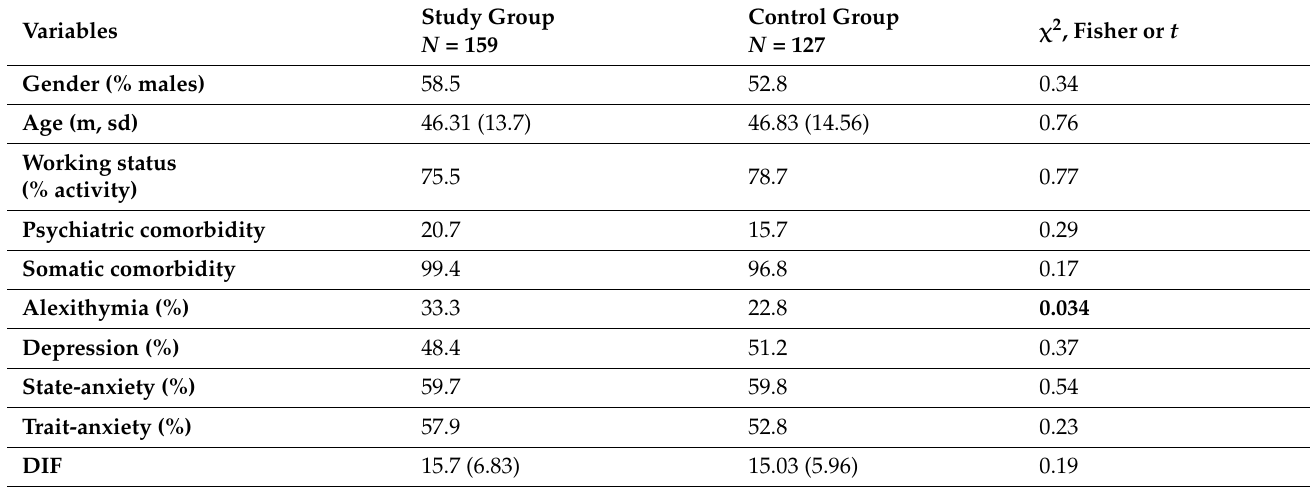
Table 1. Demographic and psychometric characteristics of the two